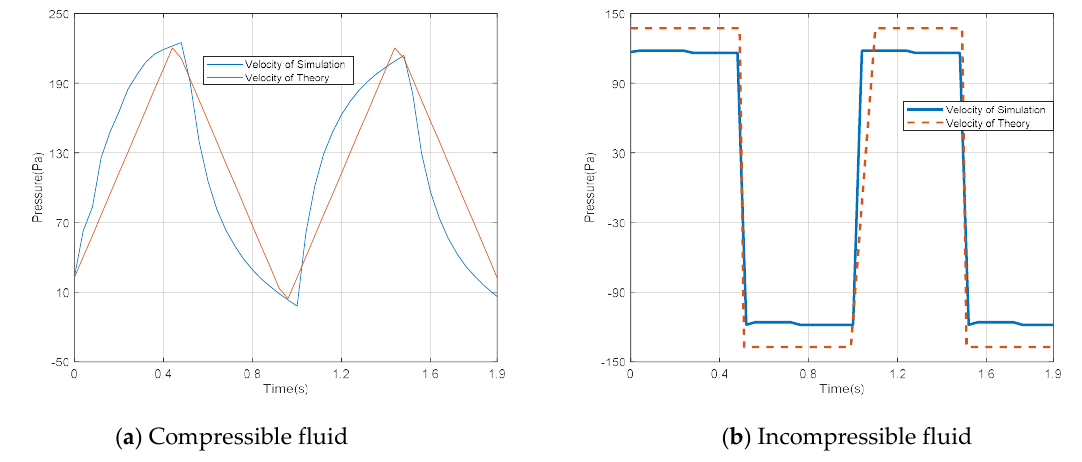
Figure 10. The pressure of case 2 on the line X = 0.